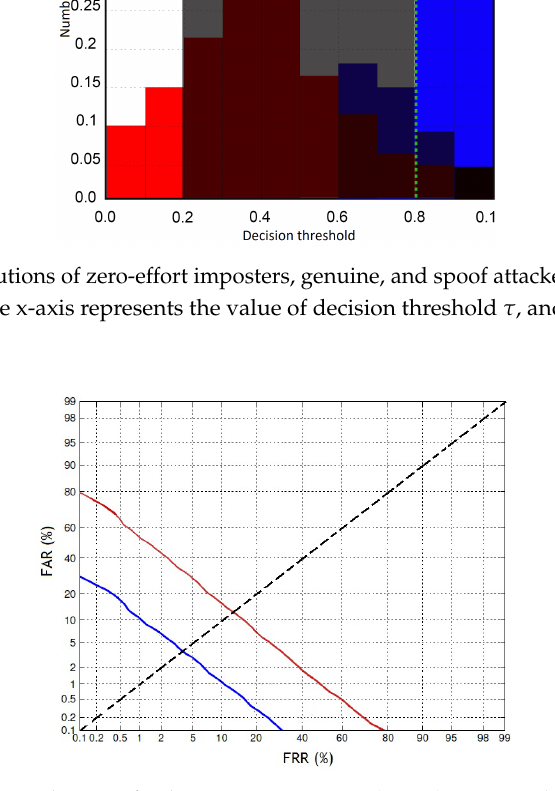
Figure 8. DET determines the Spoof False Acceptance Rate (SFAR); EER on the decision threshold τ illustrated from the development